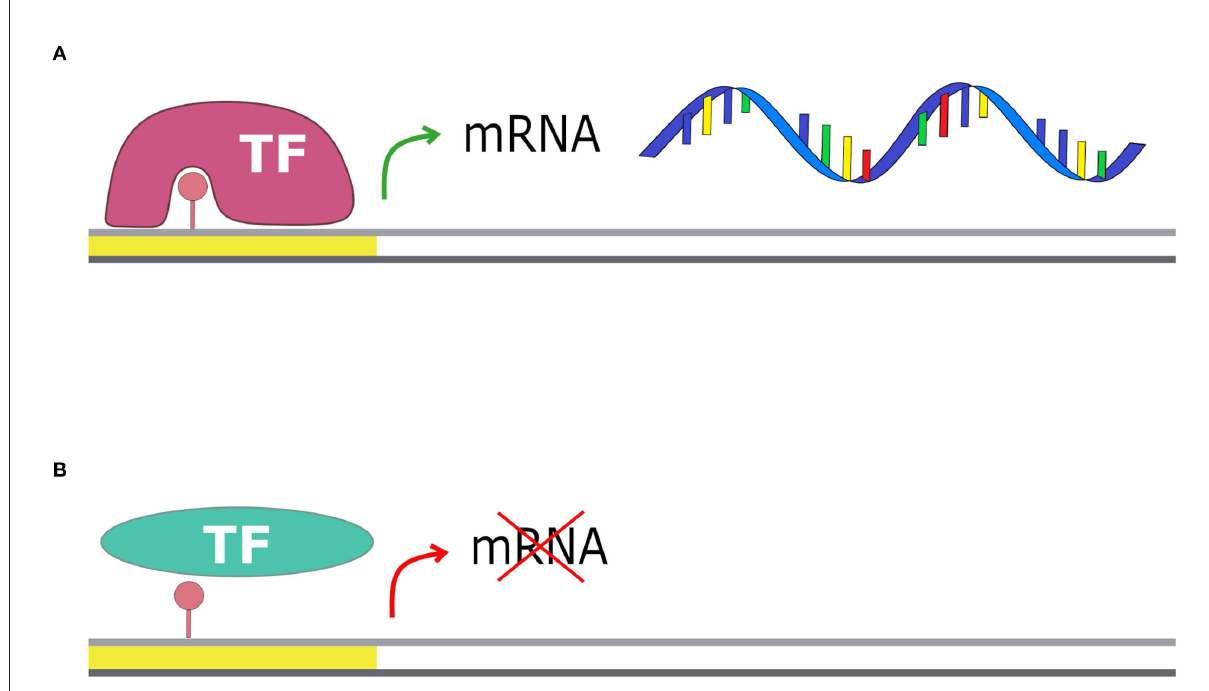
FIGURE4 Methylation and transcription. The presence of a methyl group on the promoter region can affect gene transcription: (A) if the transcriptional factor has more affinity for the methylated motif, the transcription is enhanced; (B) if the transcriptional factor has less affinity for the methylated motif, it cannot bind the promoter and transcription is